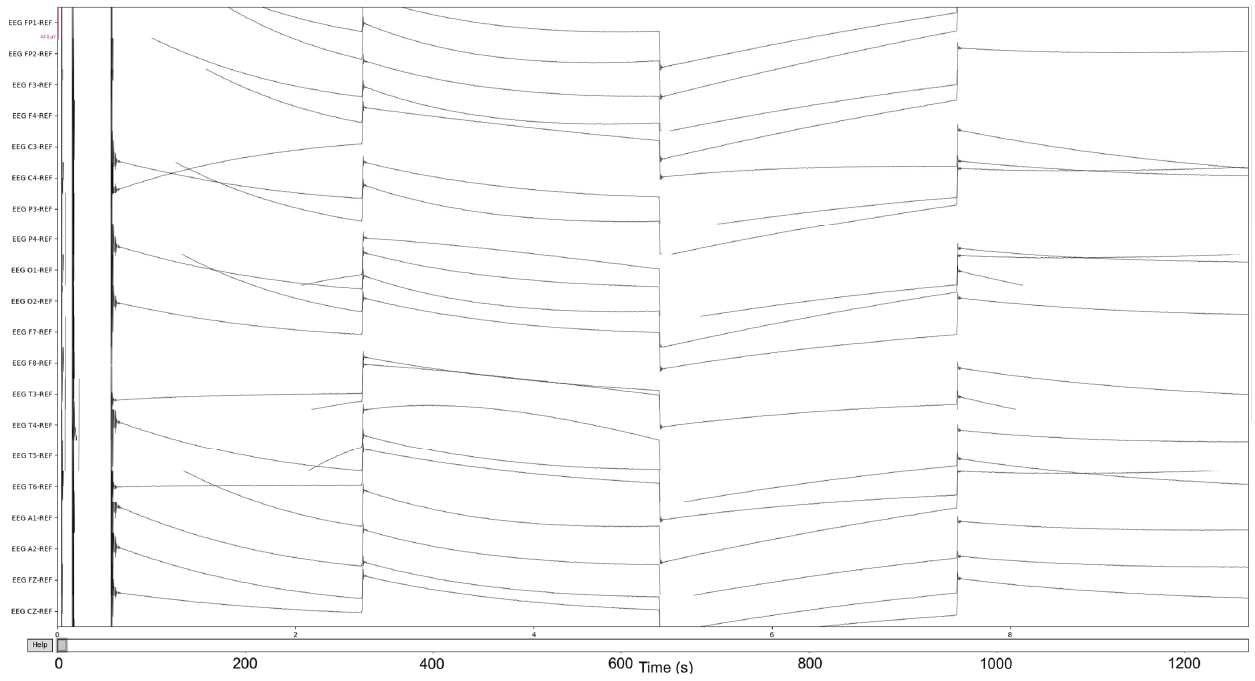
Figure 4. The pre-Reduction visualization of the EEG recordings.